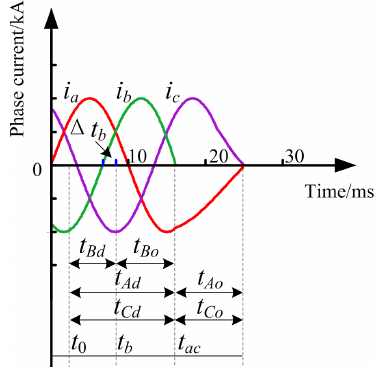
Figure 4. Sequence of closing capacitor banks with phase selection.